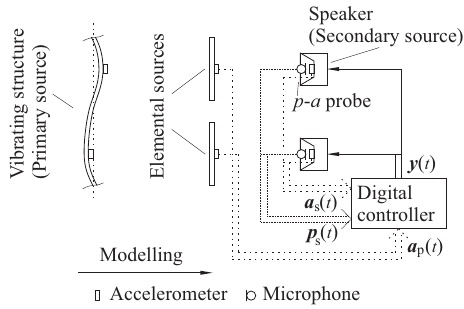
Figure 1: Concept for total active sound power minimization